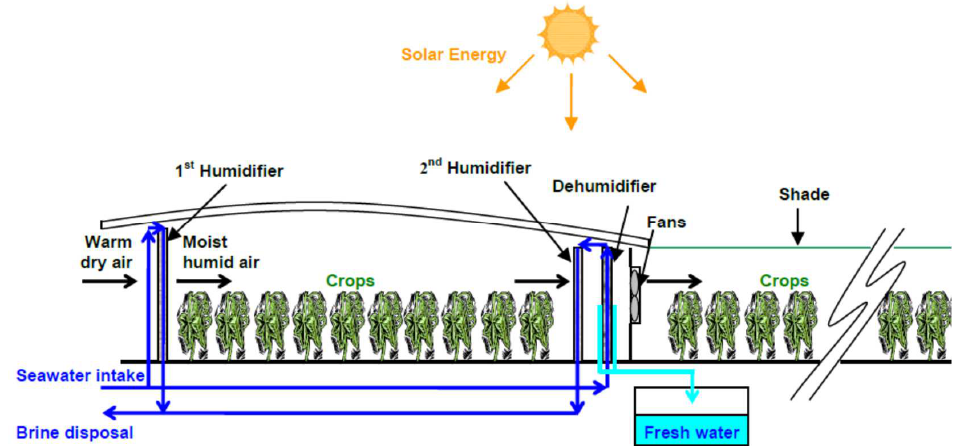
Figure 20. Schematic of the seawater HD GH. Reproduced with permission from M. F. A. Goosen,